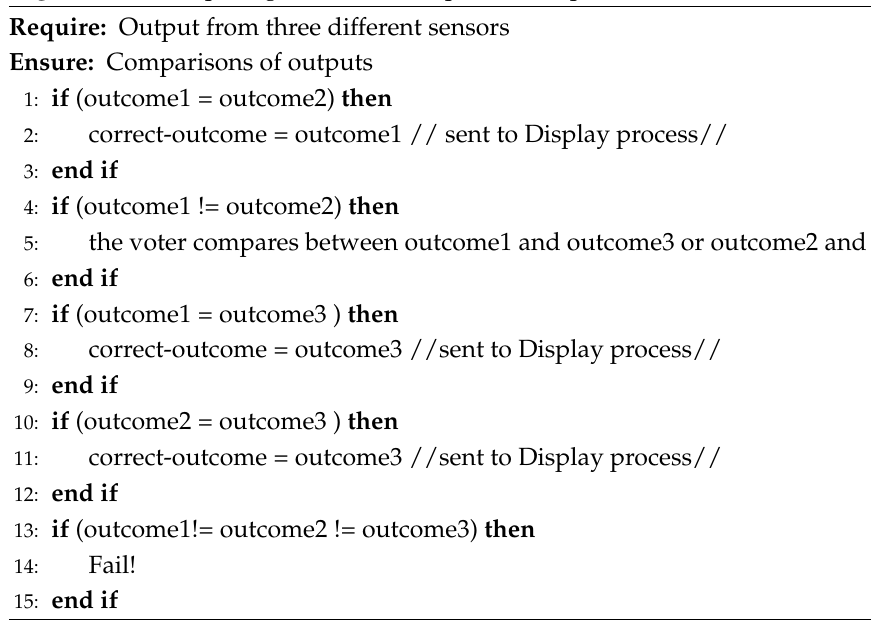
Algorithm 1 Comparing sensor control process